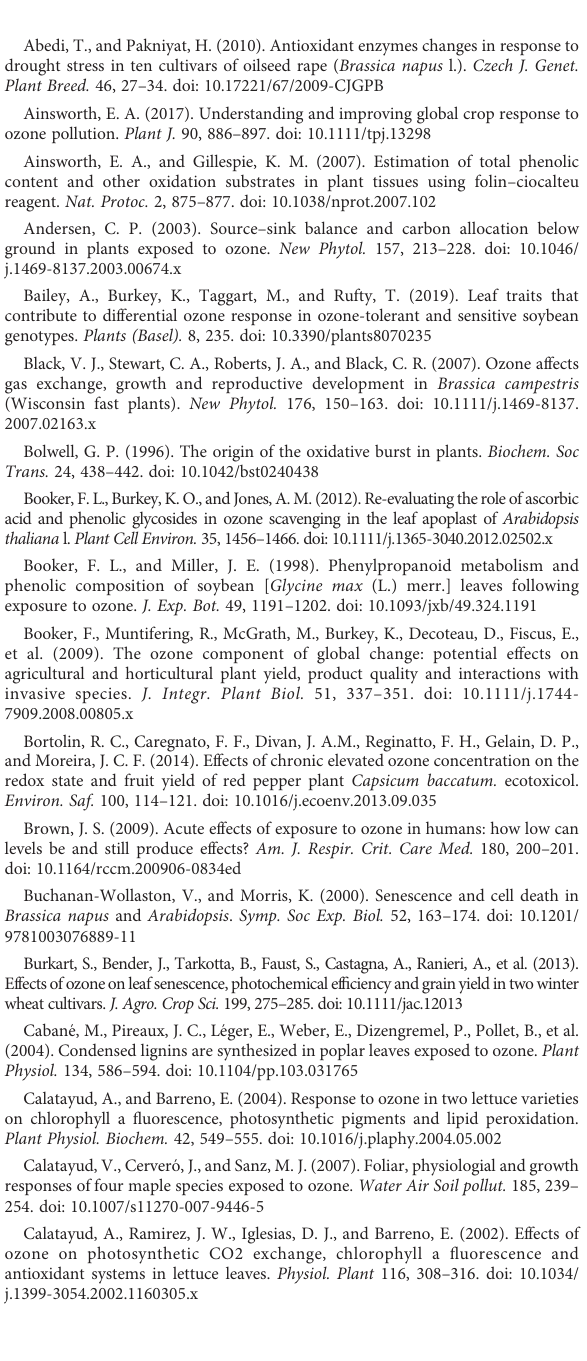
SUPPLEMENTARY FIGURE 2 Phenylpropanoid, fl avonoid, and anthocyanin biosynthetic pathways. The genes analyzed in this study are marked in